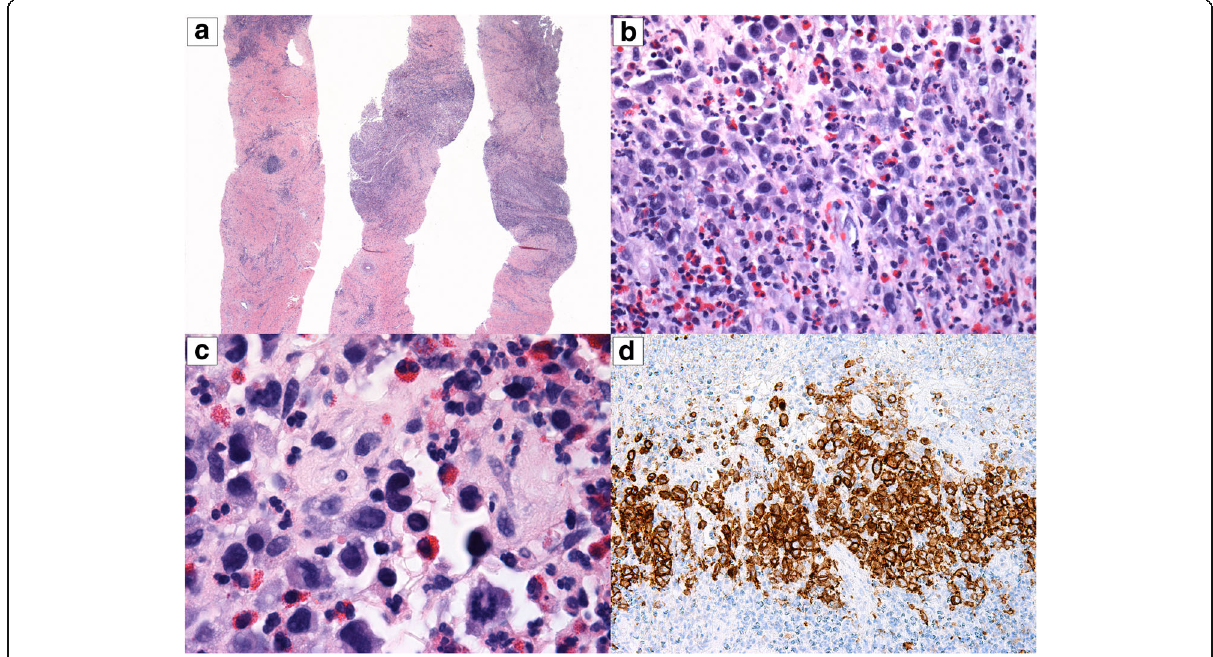
Fig. 2 Breast implant-associated large cell lymphoma on core-needle biopsy. a Fragments of fibrous tissue exhibiting dense foci of lymphoid cells (H&E, 20×). b These foci are constituted by large atypical lymphoid cells interspersed with granulocytes, especially eosinophils (H&E, 400×). c Some of the large cells show kidney-shaped nuclei, the so-called “ hallmark cells ” (center of the field) (H&E, 1000×). d Strong membranous expression of CD30 in the neoplastic cells (200×)